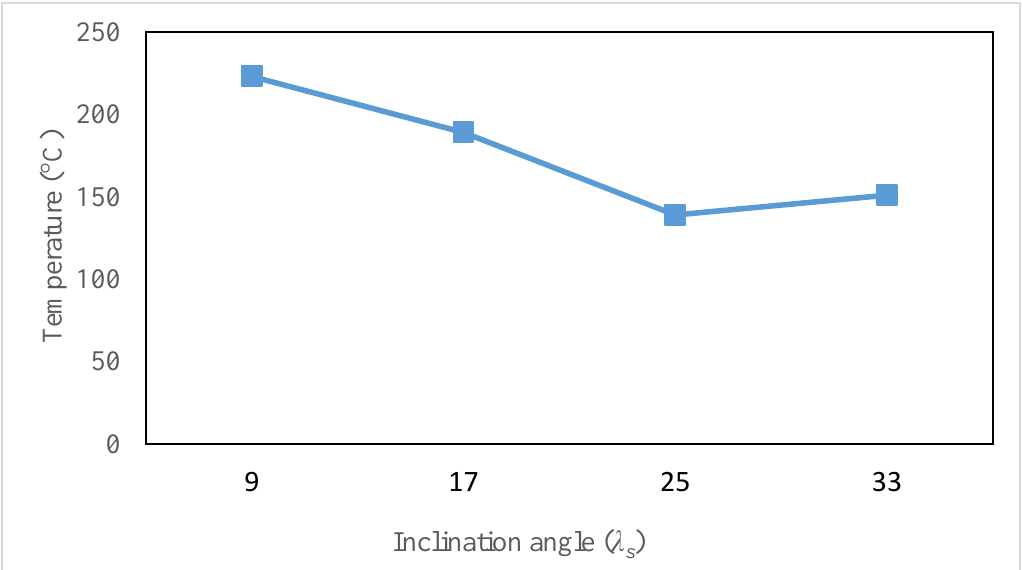
Figure 11. Temperature contours on the tool cutting edge at different inclination angles ( V = 100 m/min).